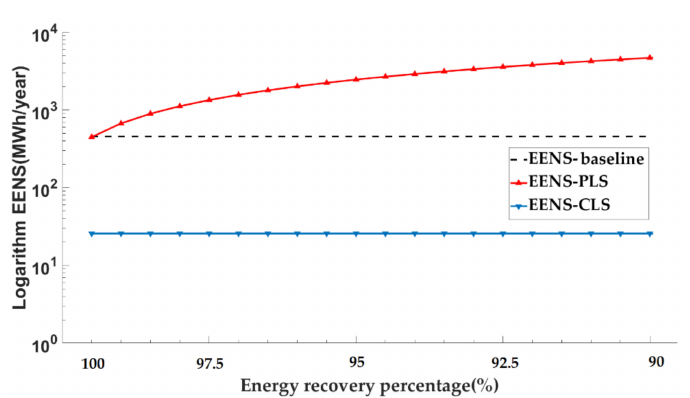
Figure 10. EENS of PLS and CLS for Model 1.